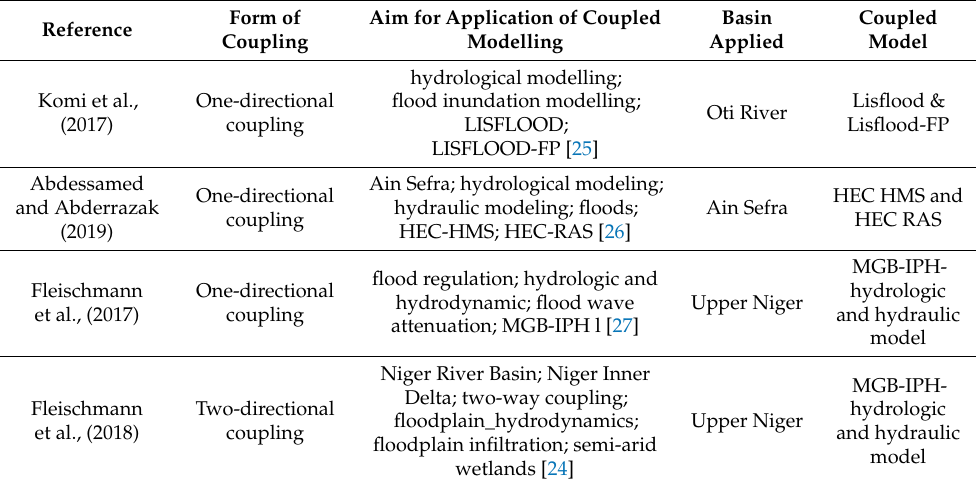
Table 1. Results of peer-reviewed case studies that used coupled hydrologic-hydraulic modelling in floodplain studies in